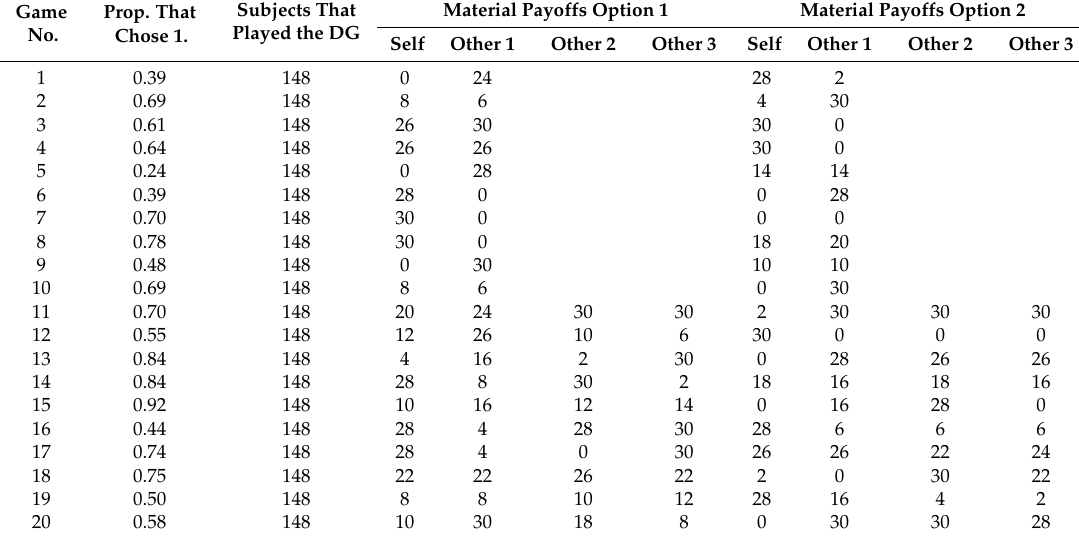
Table 3. Descriptive statistics and material payoffs for the two- and four-player DGs in Experiment 1. Game Prop. That No. Chose 1.